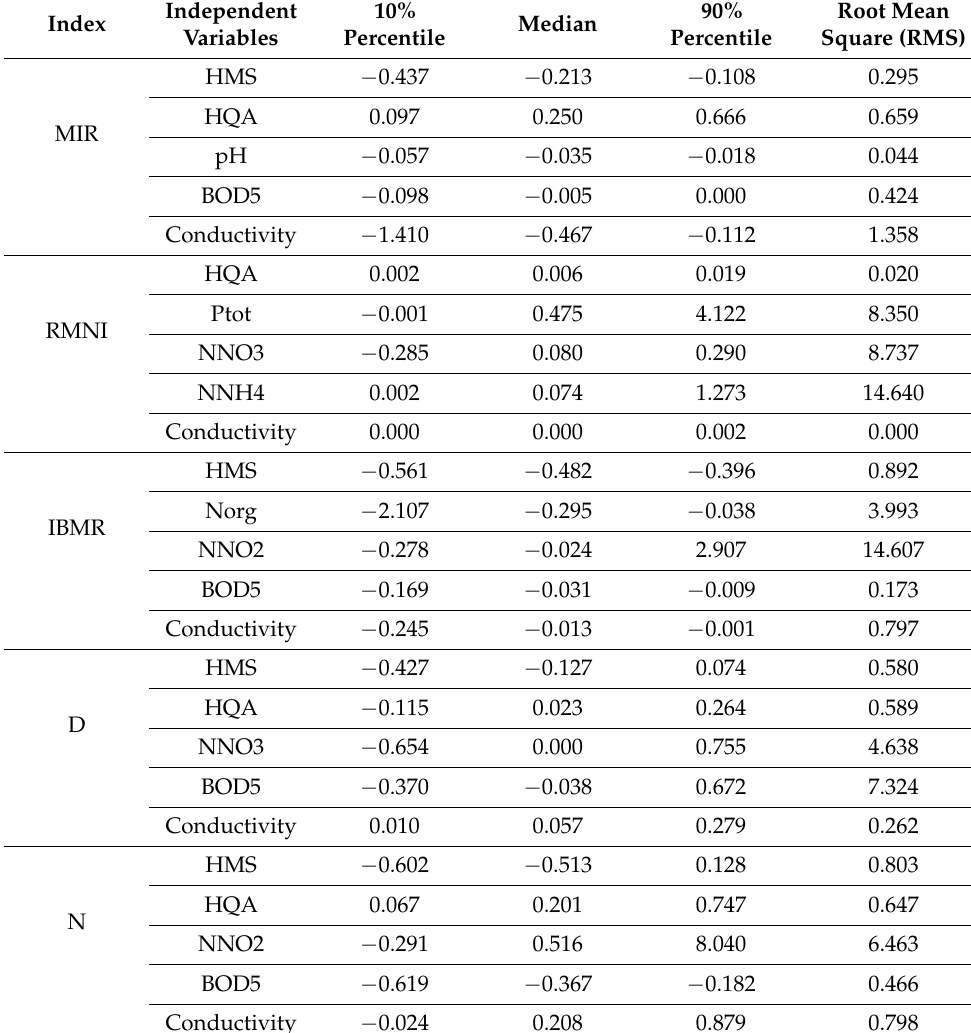
Table 5. Independent variable importance ratio